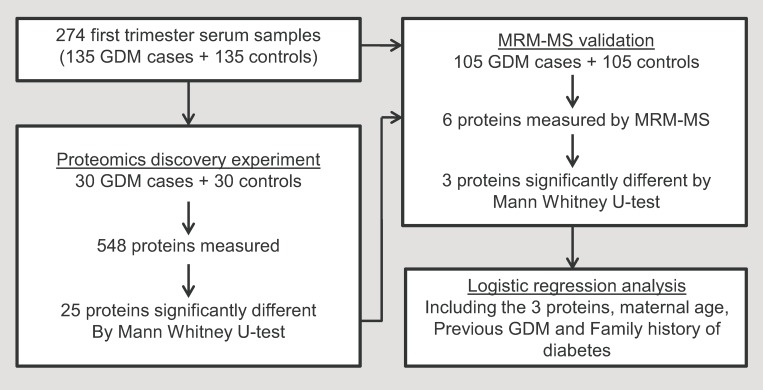
Study workflow.The study comprise two distinct stages; first a proteomics discovery part, for GDM biomarker identification and secondly a MRM-MS validation part.